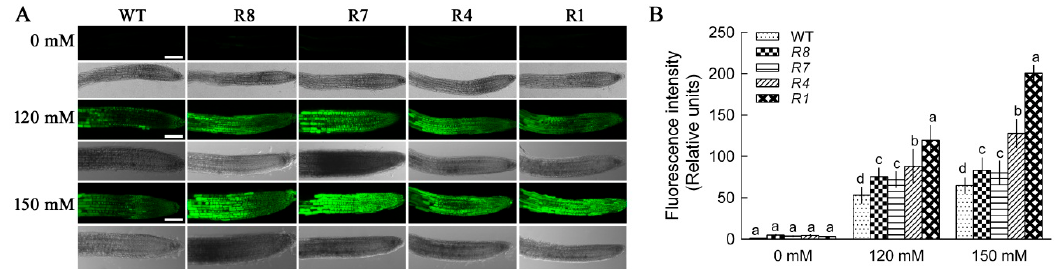
Figure 5. Na + levels in root cells of wild-type (WT) GL1 and CPK12 -RNAi plants under salt stress. ( A ) Seven-day-old seedlings were transferred to MS medium supplemented with (120 mM, 150 mM) or without NaCl (0 mM) for 12 h, then seedlings were treated with CoroNa-Green AM (green fluorescence, sodium-specific) for 1 h. Green fluorescence in root cells was observed at the apical region of roots using a Leica confocal microscope. Typical images show Na + content in plant roots. Scale bars, 100 μ m. ( B ) The mean relative fluorescence values marked with letters in the same group represent significant differences ( p < 0.05).